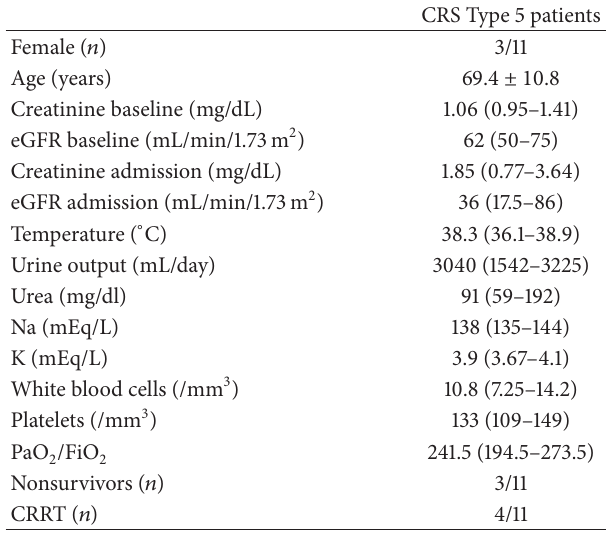
Table 1: Clinical and biochemistry parameter about CRS Type 5 patients